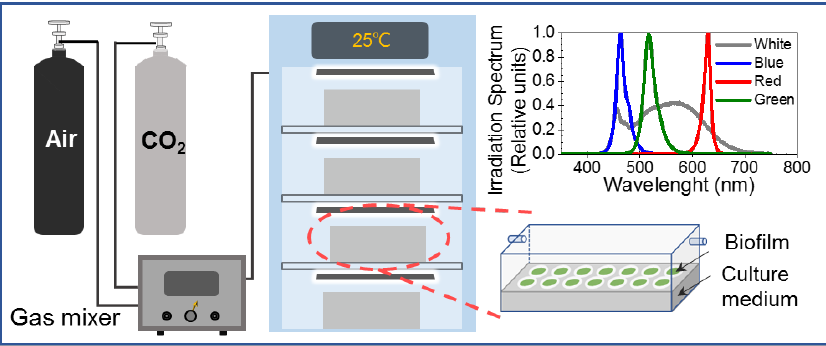
Figure 1. Schematic diagram of the microalgae biofilm culture system.